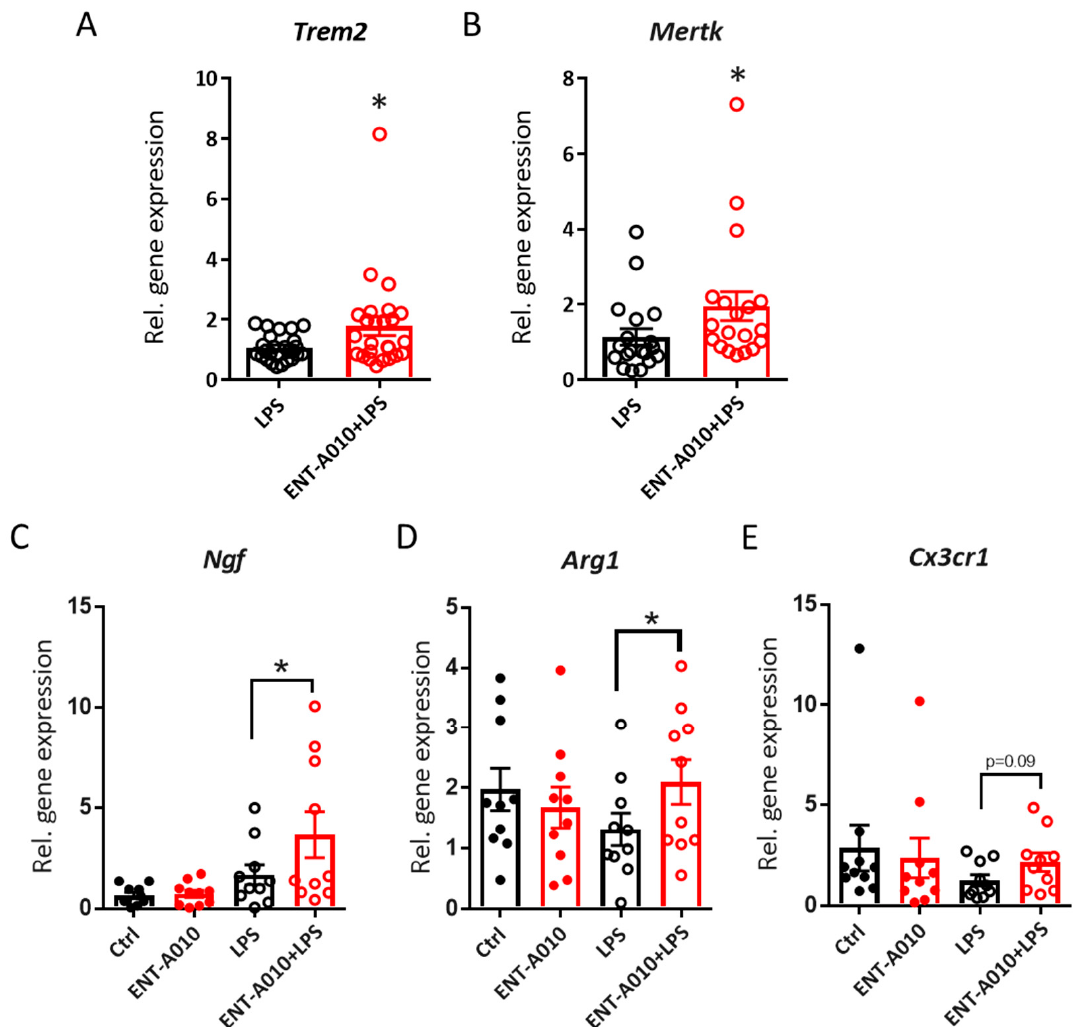
Figure 7. ENT-A010 promotes a protective microglial phenotype in vitro. Primary microglia were treated with 1 µ M ENT-A010 on two consecutive days, and 1 h after the second treatment, they were stimulated with 100 ng/mL LPS. The expression of indicated genes was analyzed by qPCR. Data are shown as mean ± SEM n = 25 for ( A ), n = 19 for ( B ), n = 10 for ( C – E ) *: p < 0.05.